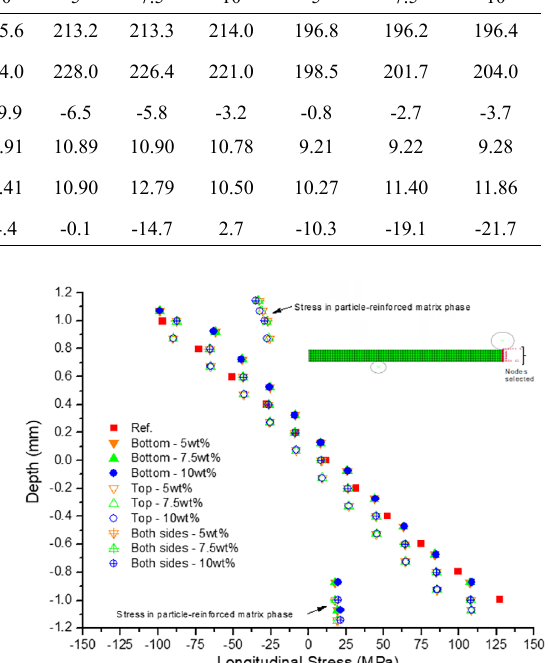
increases the area of the section under compressive loads when subjected to bending. An opposite behaviour is obtained when the particles are added to the top beam side (Figure 5b). It is well known that the matrix phase is responsible for the compressive loads while the fibres withstand the tensile loadings. In this case, the inclusion of particles on the bottom surface is more favourable because they strengthen the upper beam side by increasing the compressive area, as previously revealed by the FEA, i.e. a higher level of stress in the regions where the particles are